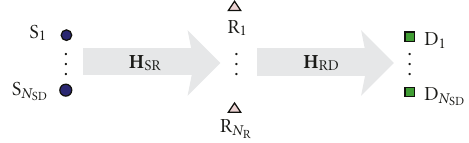
Figure 1: Two-hop system configuration with half-duplex